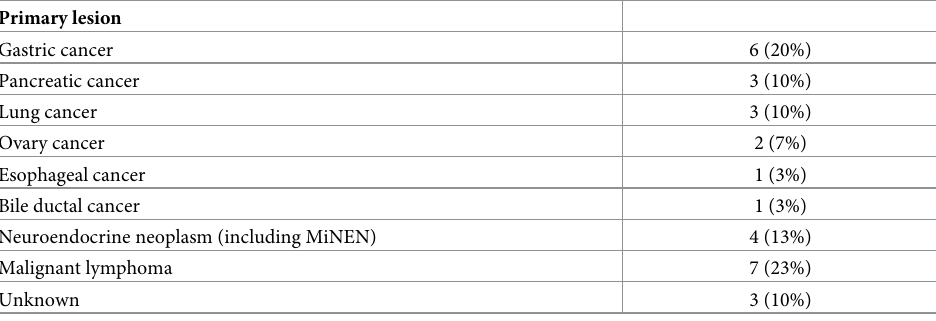
Table 2. Primary lesion of malignant